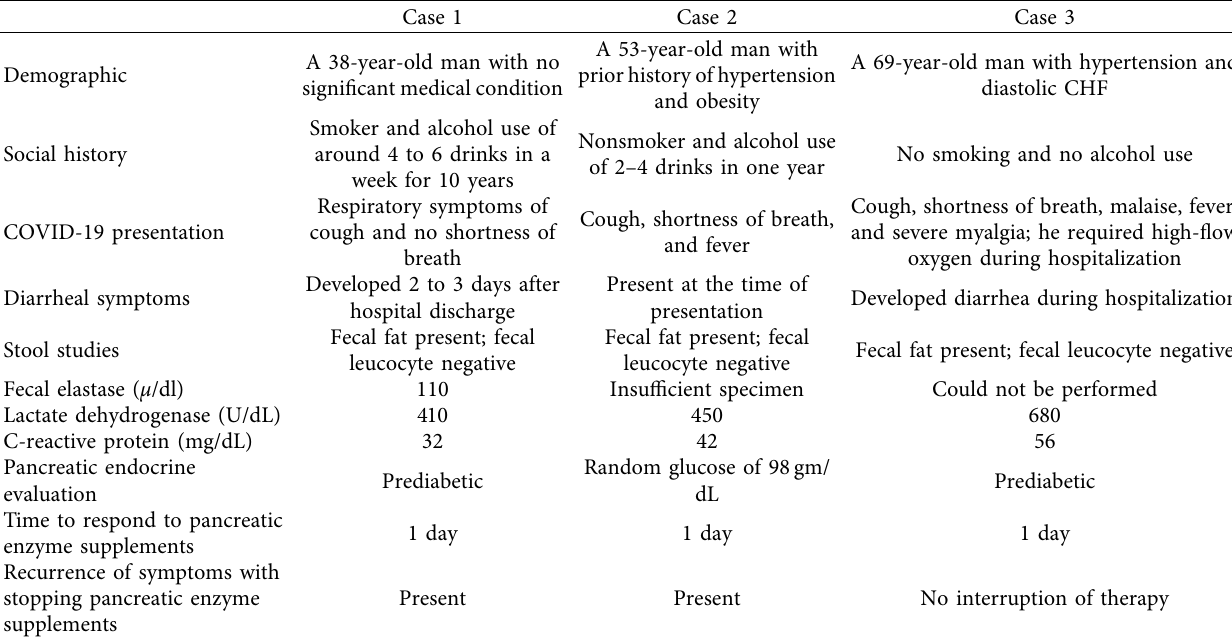
Table 1: Comparison of key presenting